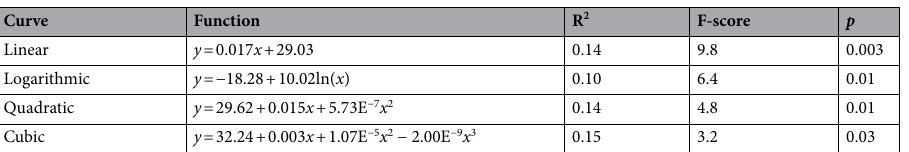
Table 2. Model summary of proportion of tumor cells with loss of BAP1 expression as a linear, logarithmic, quadratic and cubic function of tumor volume. y , proportion of tumor cells with loss of BAP1 expression. x , tumor volume in mm 3 .